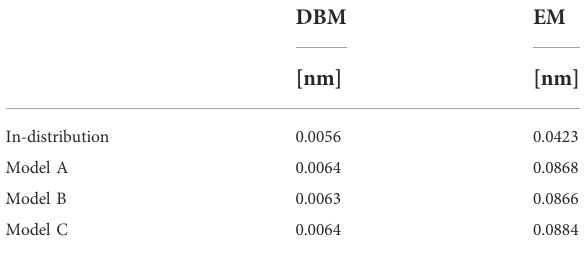
TABLE 1 Root mean-square deviations for in-distribution and generalization test sets computed between backmapped and original coarse-grained con fi gurations.